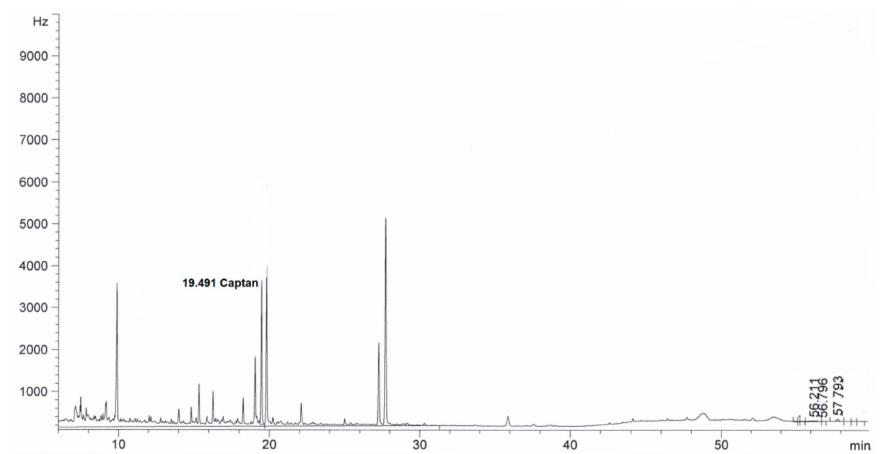
Figure 6. The chromatogram (GC- µ ECD) of industrial wastewater with the clean-up step using the dSPE (1 g ZrO 2